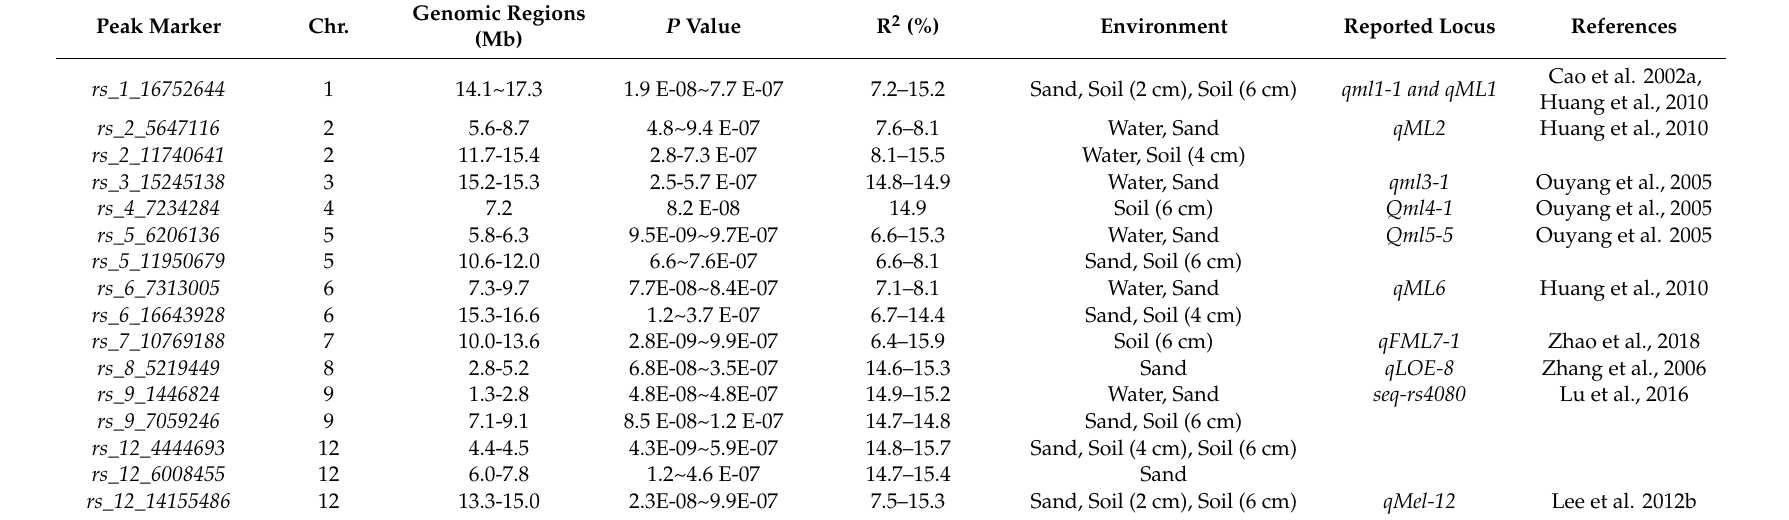
Table 2. Loci significantly associated with mesocotyl length under di ff erent